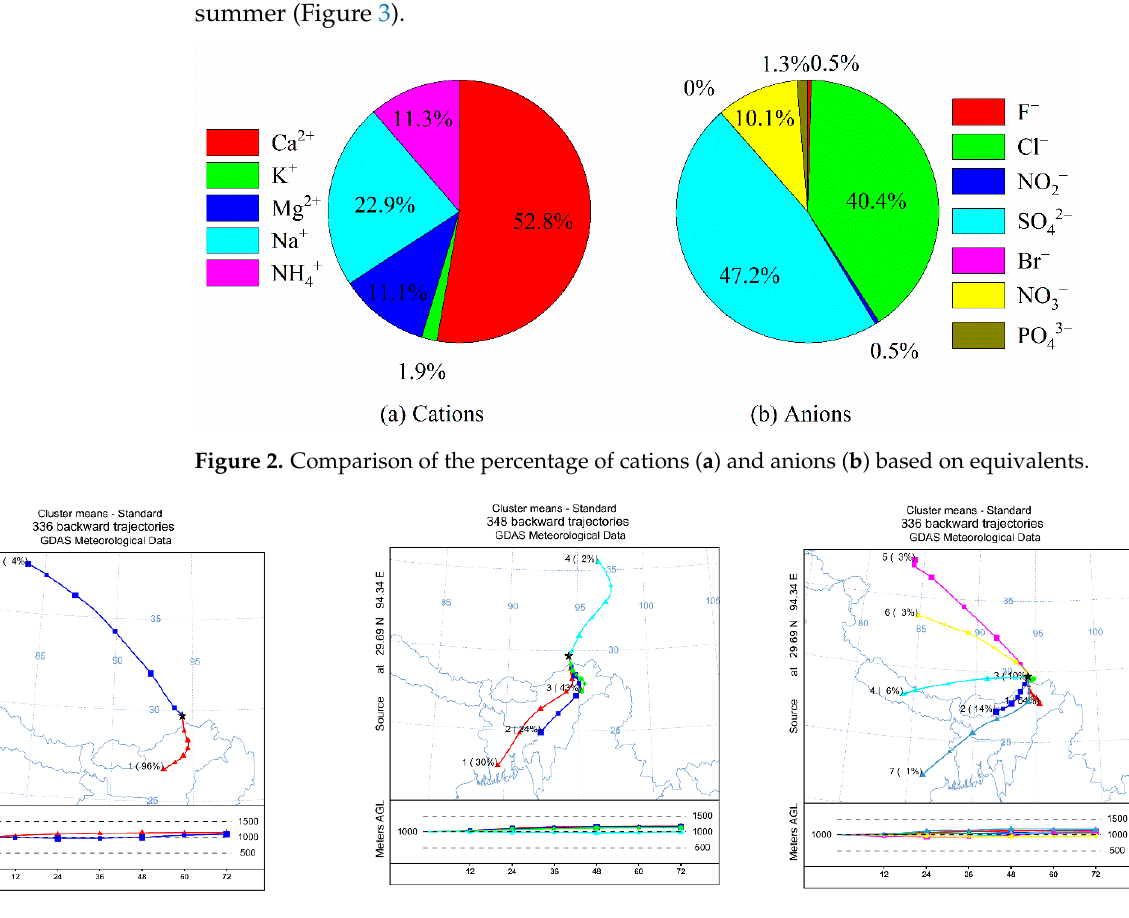
Figure 3. The 72-hour backward trajectories in the research area in different seasons. ( a )—spring; ( b ) — summer; ( c ) — autumn. Cluster analysis was performed using the trajectories based on the total spatial variance (TSV) method.